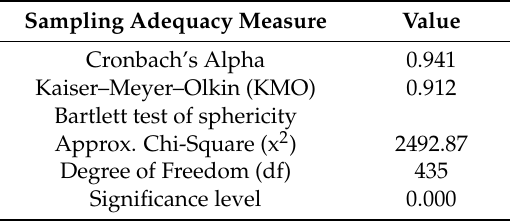
Table 6. Kaiser–Meyer–Olkin (KMO) and Bartlett